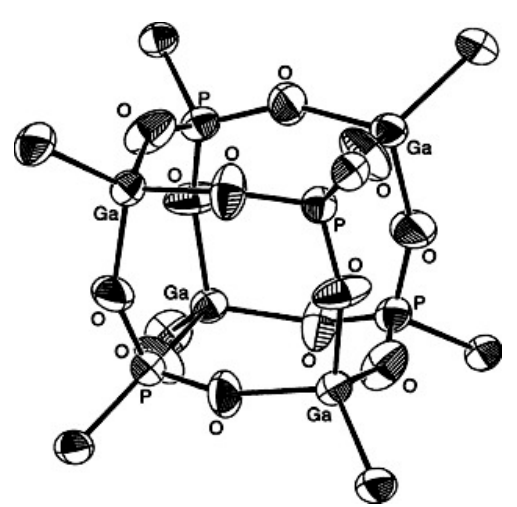
Figure 6. Crystal structure of the Ga 4 P 4 O 12 core found in [ t BuGa( μ 3 –O 3 PPh)] 4 . Reprinted with permission from reference [32]. Copyright 2003, Wiley-VCH Verlag GmbH & Co.